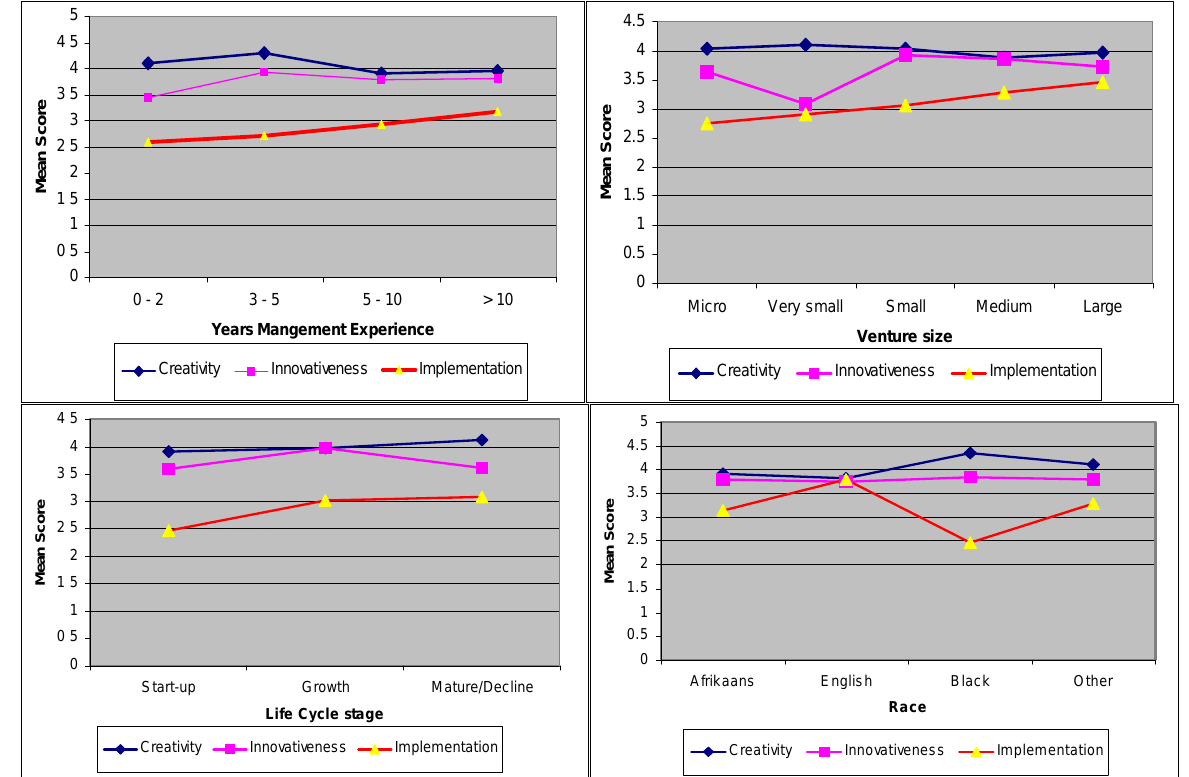
Figure 2: Mean scores for creativity, venture innovativeness and implementation orientation for management experience, life cycle stage, venture size and race Venture life cycle